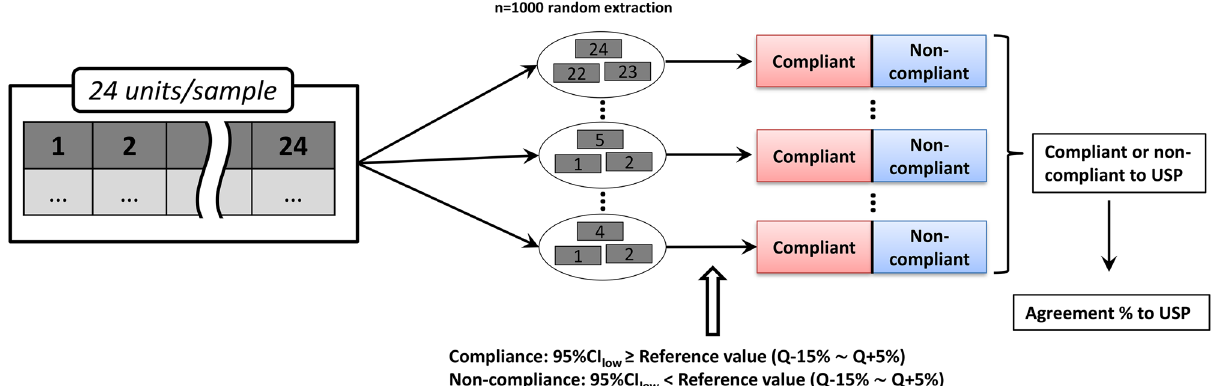
Figure 1. Schematic illustration of the bootstrap method based on the 95% confidence interval lower limit (95% CI low ) as the compliance criterion.